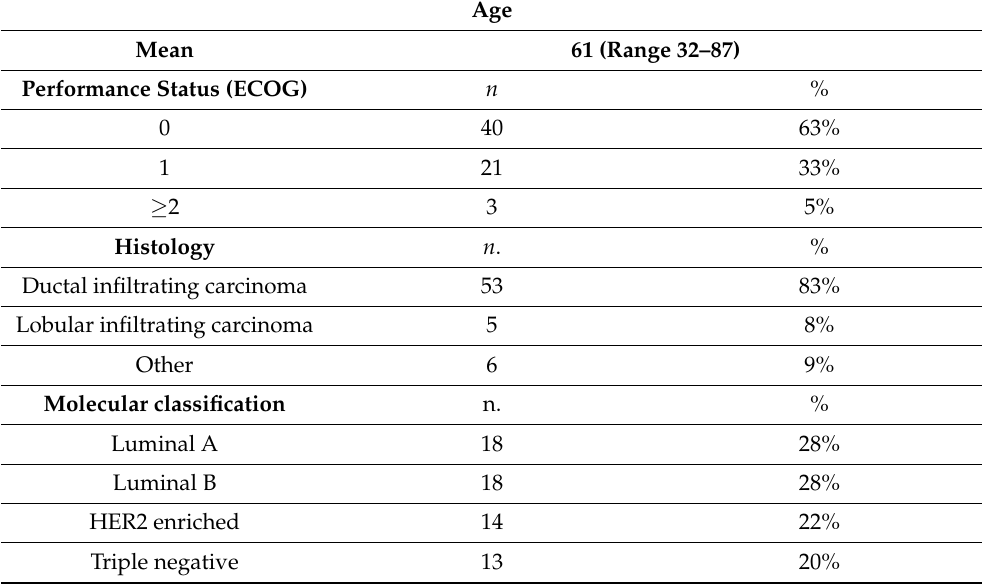
Table 3. Patients and primary disease